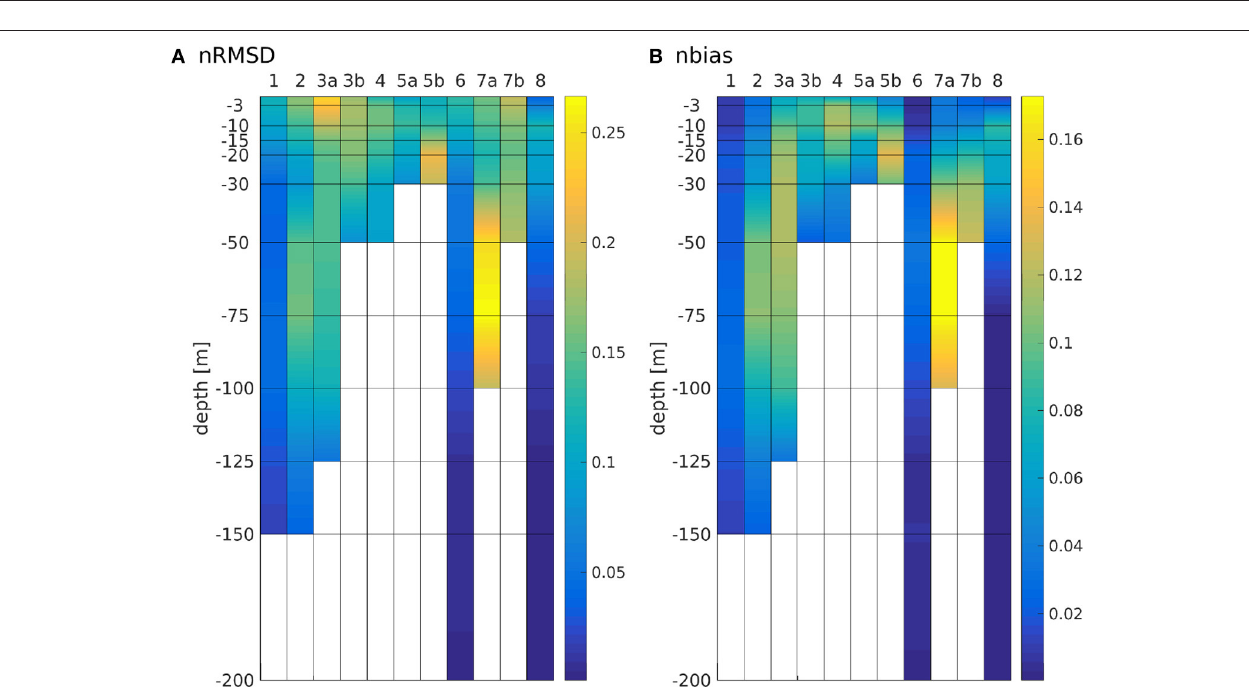
FIGURE 8 | Normalized RMSD (A) and bias (B) of chlorophyll between classic and IND for all boxes.